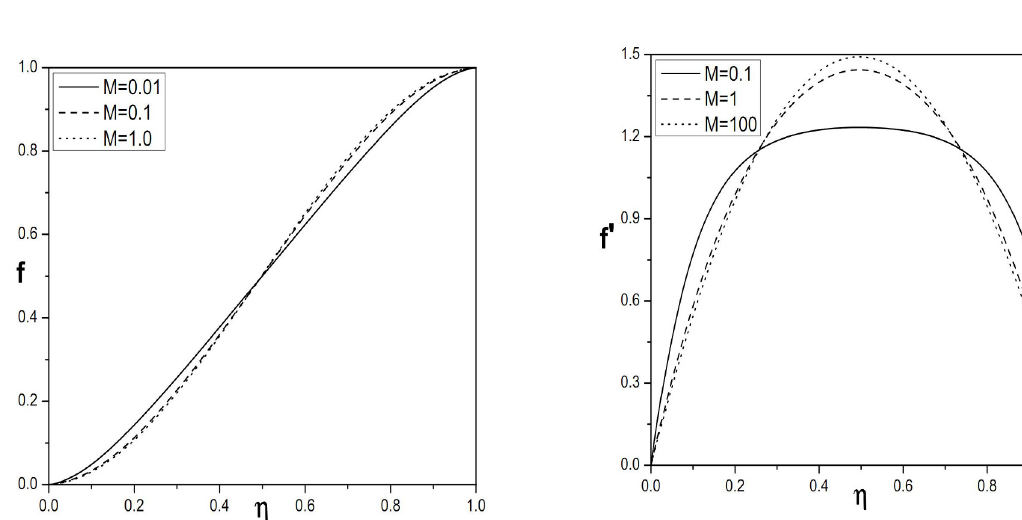
Figure 4. Effect of S on flow velocity at Re